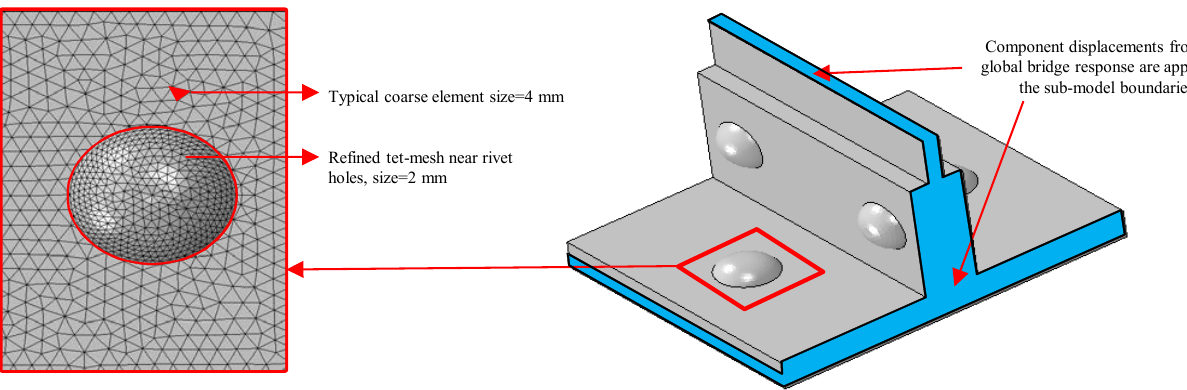
Figure 10. Joint sub-model mesh size and application of boundary